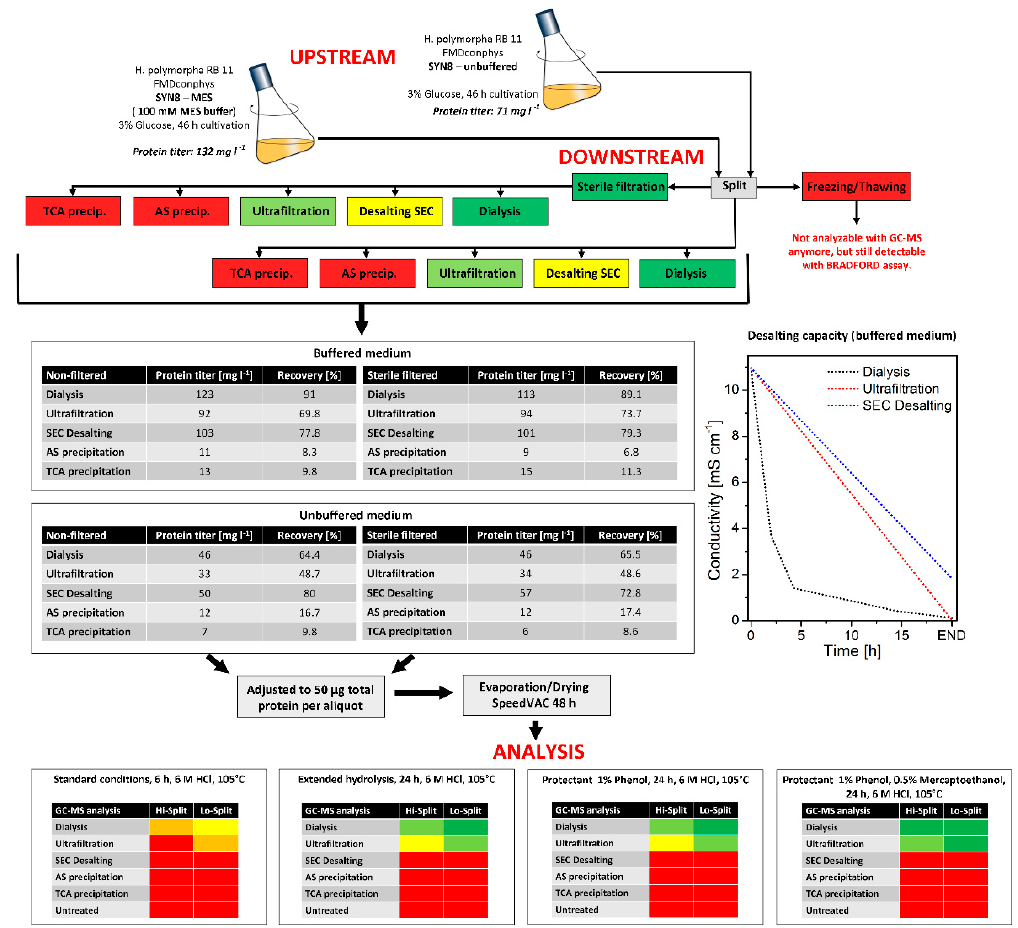
Figure 3. Evaluation of protein purification methods for secreted protein and subsequent 13 C-isotope mapping via